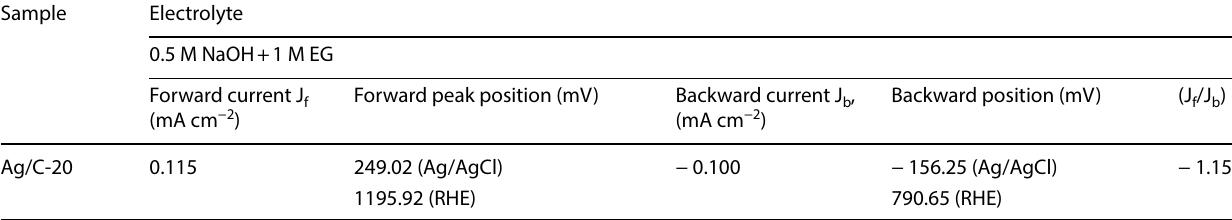
Table 2 Oxidation, reduction currents, and peak positions from Fig. 3c